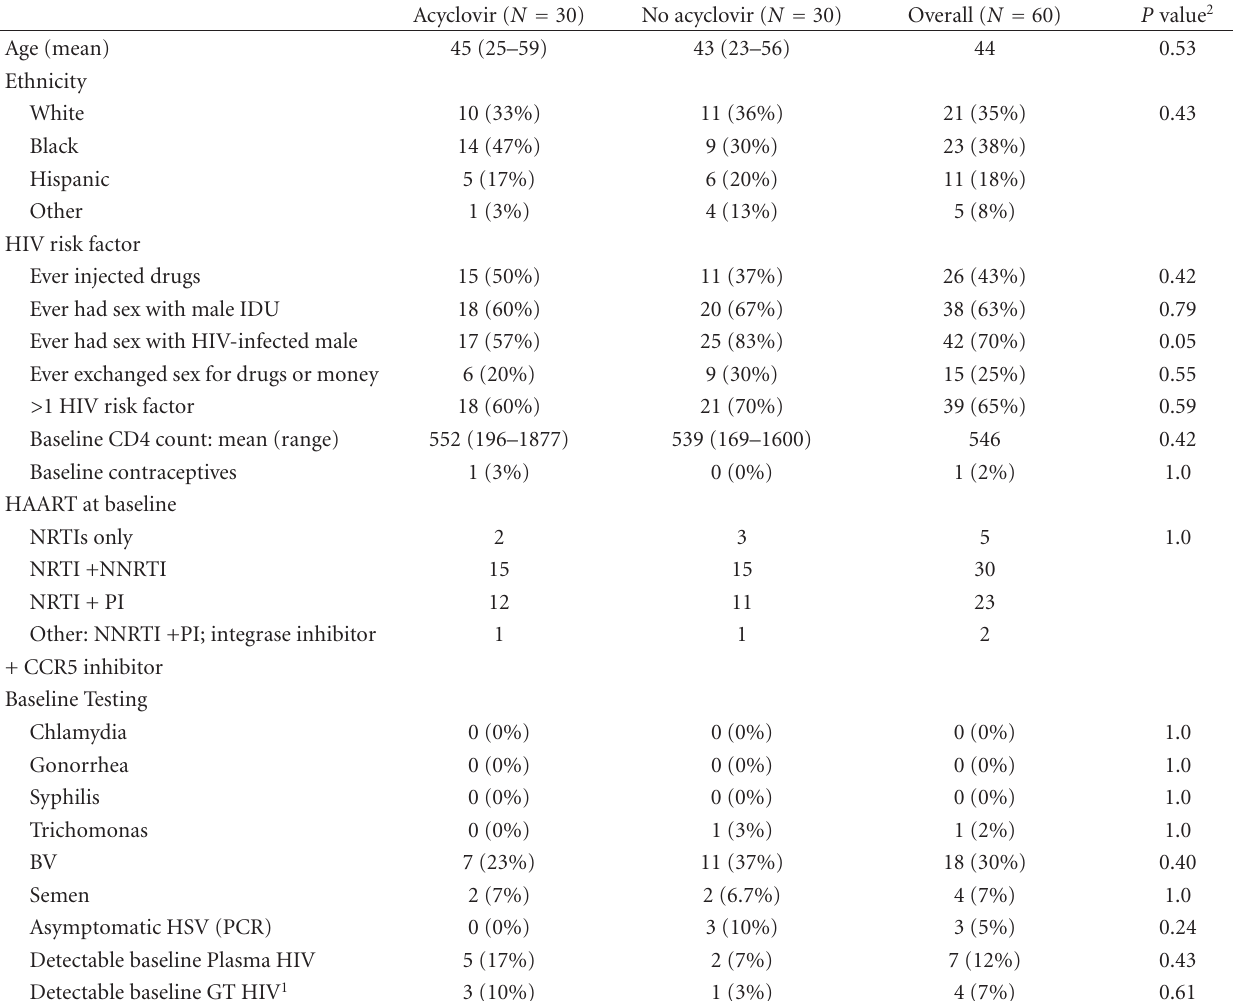
Table 1: Baseline demographic and clinical characteristics.